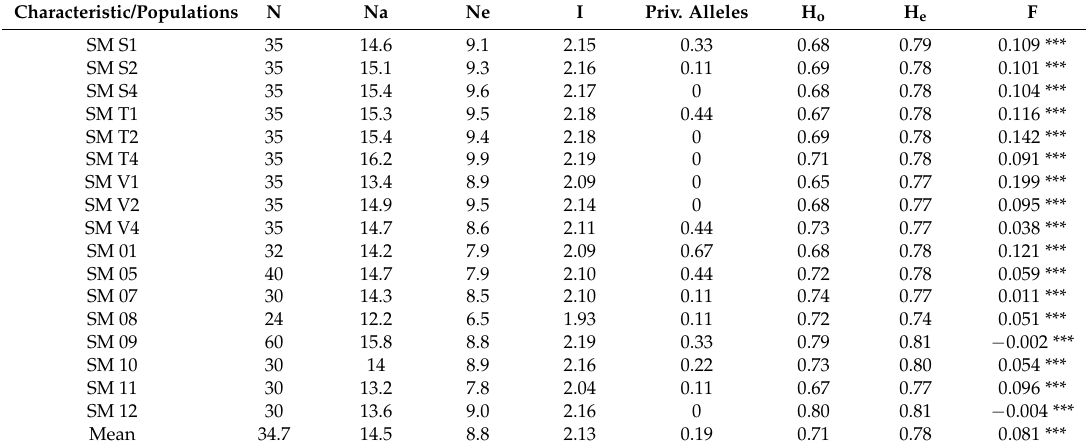
Table 3. Mean values for genetic characteristics of 17 investigated Norway spruce units from nine selected nuclear microsatellite loci. Characteristic/Populations N Na